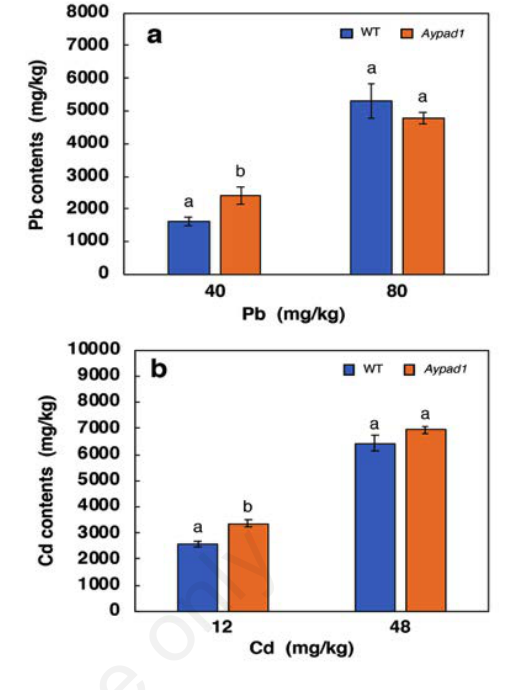
Figure 3. Accumulation of Pb (a) and Cd (b) in wild-type (WT) and Aypad1 gametophytes. After 33 days of cultivation, the game- tophytes were dried, digested with HNO , and subjected to ICP- 3 AES. The different letters indicate significant differences deter- mined by the Student's t-test (p ≤ 0.05) within the designated metal concentrations. The error bars indicate the SEs ( n =3–4).